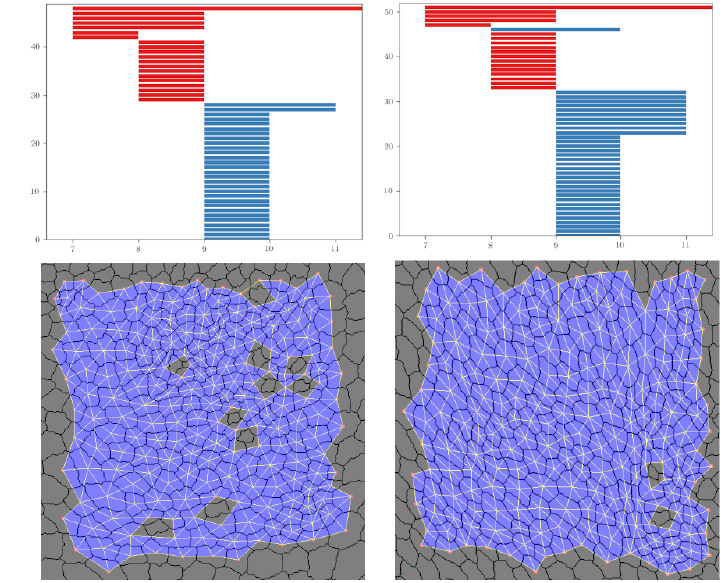
Figure 9. An example with the persistence barcodes of dWL and dWP, which provide the median for